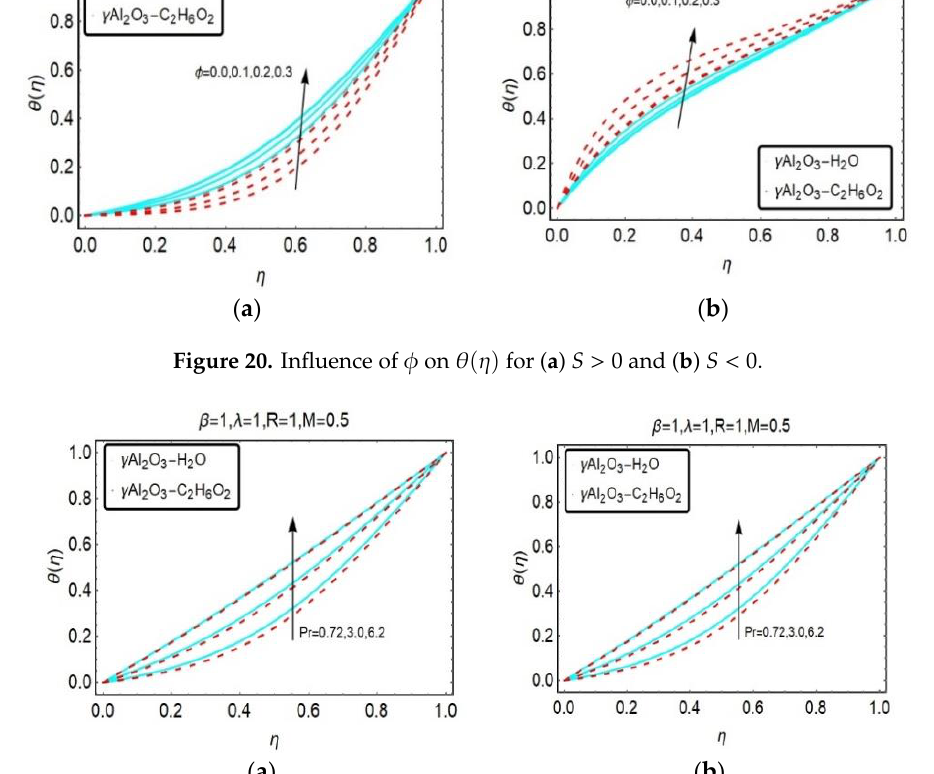
Figure 21. Influence of Pr on θ ( η ) for ( a ) S > 0 and ( b ) S < 0.